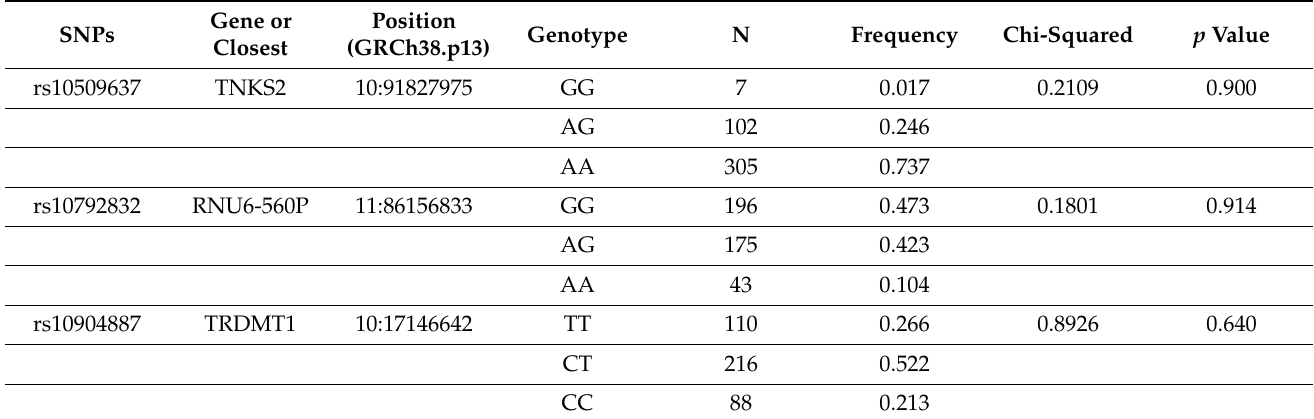
Table 2. Description of SNPs. Data from GWAS Catalog (https://www.ebi.ac.uk/gwas/home accessed on 1 September 2022). Calculation of the Hardy–Weinberg